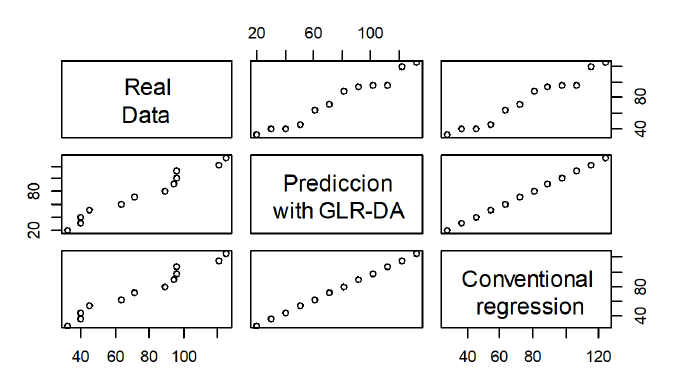
Figure 3. Correlation Chart about the comparisons.